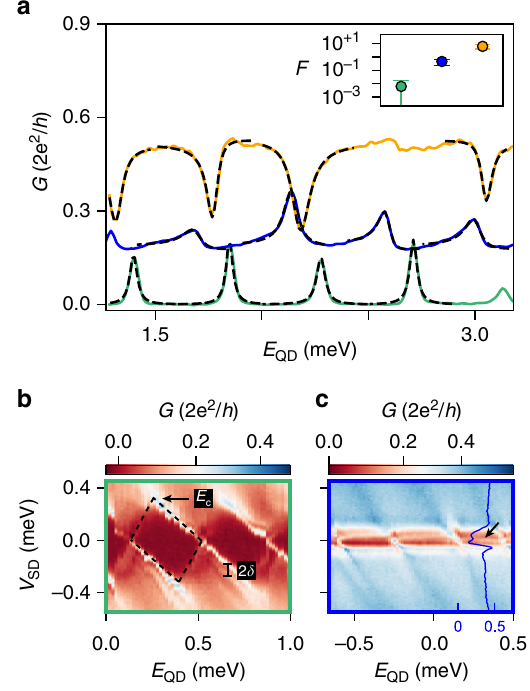
Fig. 3 From Coulomb to Fano resonances. a Differential conductance G as a function of E QD with the reference arm fully pinched-off (green trace), partially conducting (blue trace) and transparent (orange trace). Dashed lines are best fi ts. Inset: Fano parameter F ¼ t four peaks in each of the three regimes. b , c G versus E QD and V SD in the fi rst and second regime, respectively. The blue line-cut in ( c ) is taken at E = 0.32 meV, the blue values on the horizontal axis refer to QD conductance G in 2 e 2 / h . In ( b ), E c indicates the charging energy (at the apex of the diamond) and δ denotes the level spacing due to quantum con fi